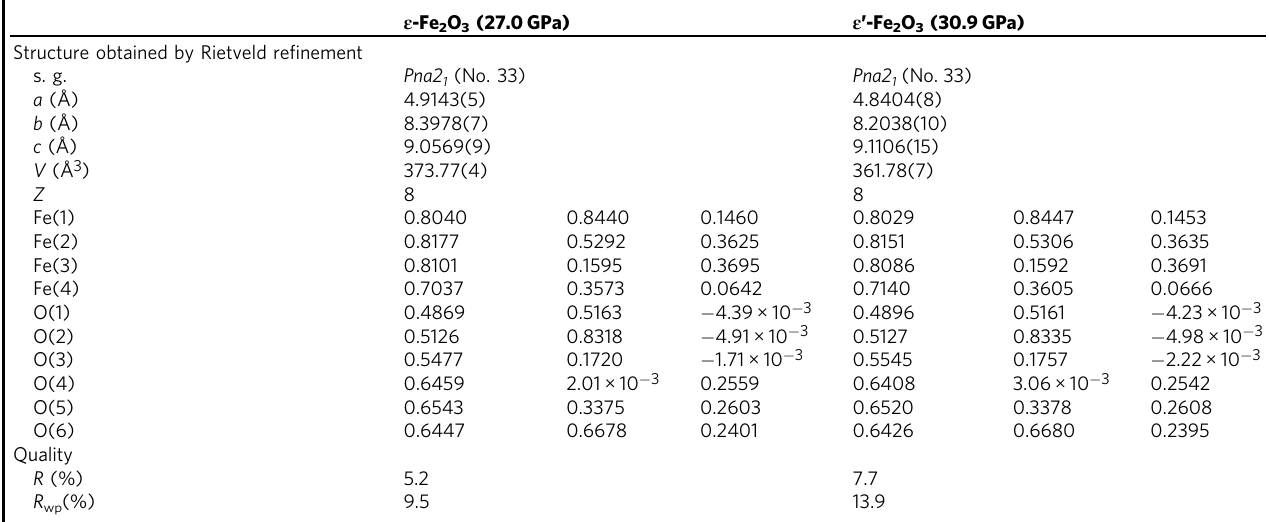
ε ’ -Fe 2 O 3 (30.9 GPa)